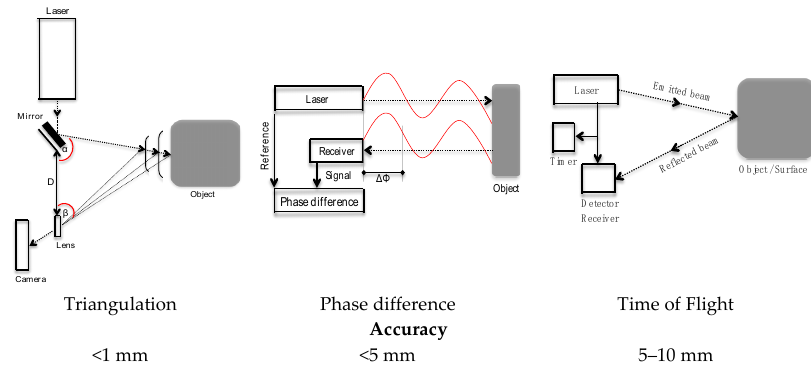
Figure 3. Systems and Accuracy of the terrestrial laser scanning (TLS). Source: Own figures.